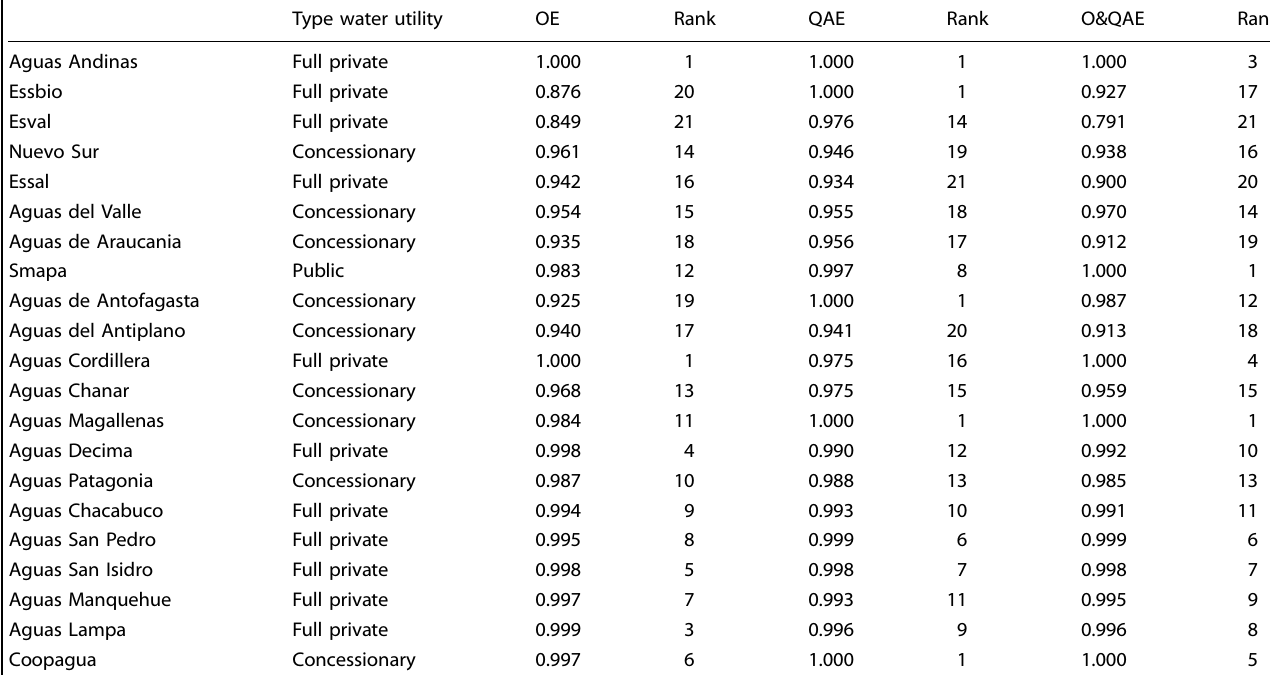
Table 1. Ranking of Chilean water utilities based on operational ef fi ciency (OE), quality-adjusted ef fi ciency (QAE), and operational & quality-adjusted ef fi ciency